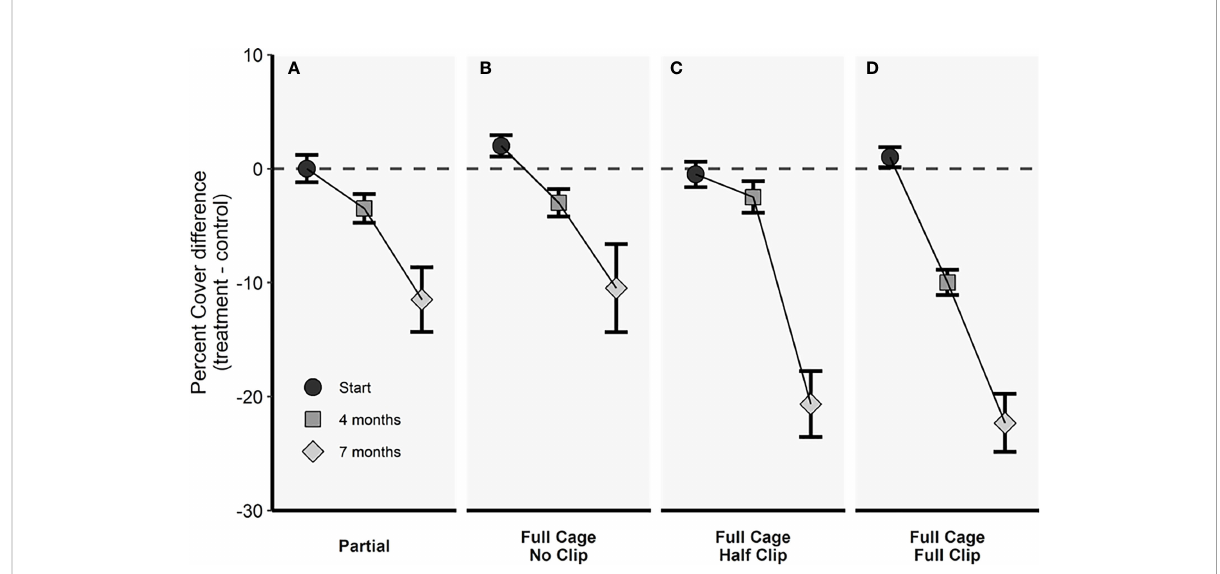
FIGURE 8 Thalassia testudinum percent cover treatment-control values (± 1 SE) for (A) Partial cages, (B) Full cages with no clipping treatment, (C) Full cages with half clipping treatment, and (D) Full cages with full clipping treatment throughout the caging study. The dotted line represents where there would be no difference between the treatment and control